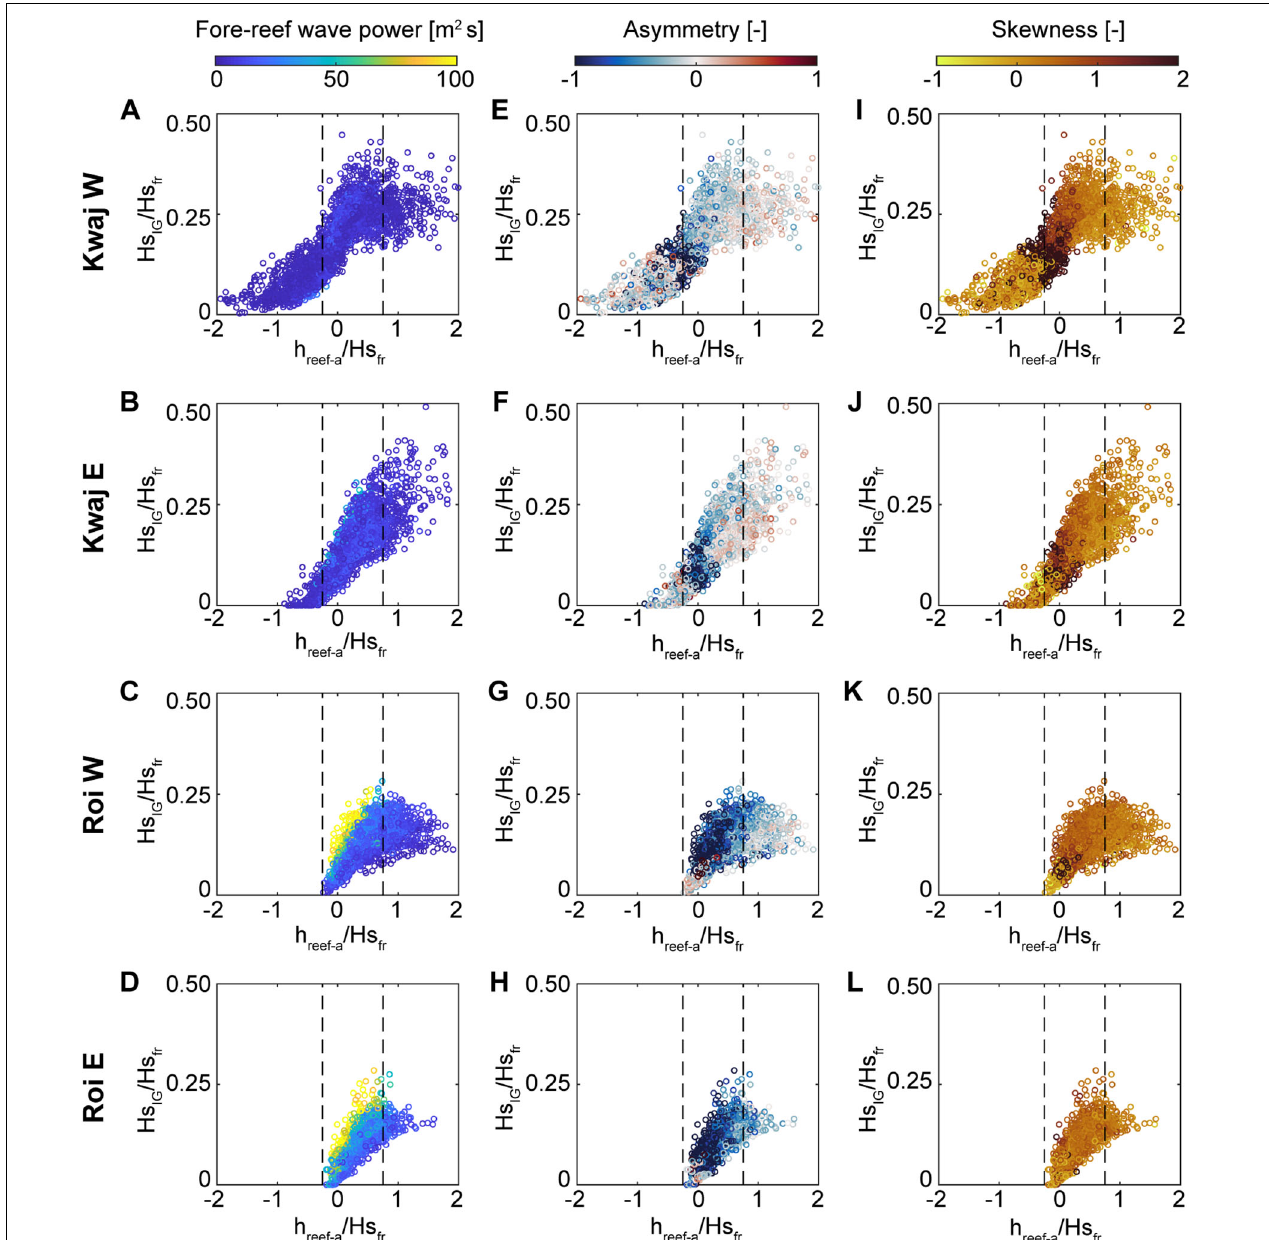
FIGURE 5 | Evaluation of the relationship between mean reef-flat infragravity wave heights ( Hs IG ) and the ratio of the water level relative to the reef flat ( h reef − a ), normalized by fore-reef wave heights ( Hs fr ) for the four sites with large infragravity waves: Kwajalein W, Kwajalein E, Roi-Namur W, and Roi-Namur E reefs (each site is a row). The h reef − a is the reef submergence related to fore-reef water levels above and below the mean; this was done in order to allow comparison with previous modeling results from Masselink et al. (2019). (A–D) Color-scale indicates the fore-reef wave power. (E–H) Color-scale indicates asymmetry, with darker blues indicating more pitched-onshore, bore-like IG waves. (I–L) Color-scale indicates skewness, with darker reds indicating more peaked waves. Masselink et al. (2019) reported the largest reef flat IG waves occur when the ratio of h reef − a to Hs fr was between –0.25 and 0.75 (vertical dashed lines). In general, with increasing h reef − a / Hs fr , the relative reef-flat Hs IG become larger, and less pitched-onshore (asymmetry is less negative), and skewness lessens. Although we find the –0.25 to 0.75 window to encompass the largest relative IG waves on the Roi-Namur reef flats, the largest IG waves on the Kwajalein reefs extend beyond this window. The prevalence of IG waves with As > 0 (pitched offshore) at the Kwajalein reefs is due to shoreline IG wave reflection.